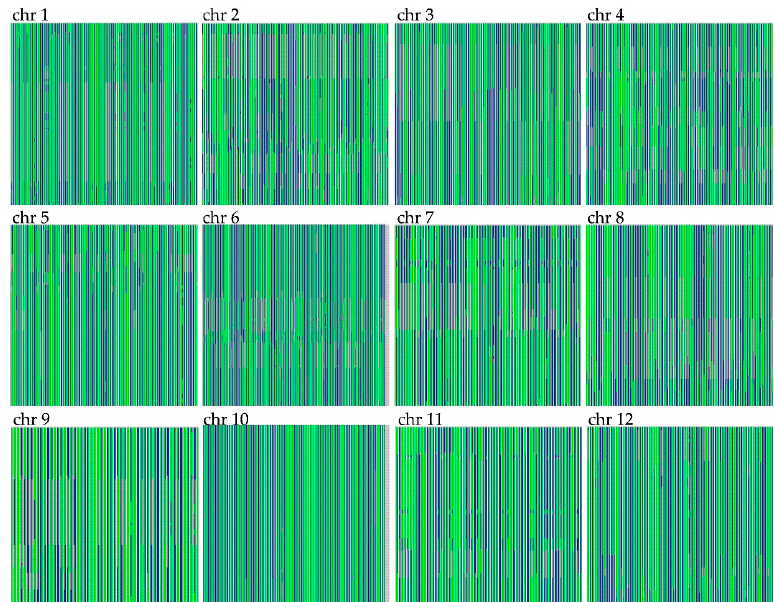
Figure A2. Haplotype maps for 12 linkage groups of the integrated genetic map for tetraploid potato. The haplotype maps consist of 12 maps from LG chr 1 to LG chr 12. Each two columns represent the genotype of an individual. Blank columns are used between two individuals. The first and second columns represent the paternal and maternal chromosome, respectively. Rows correspond to genetic markers. Green and blue boxes indicate one chromatid from parents, and gray boxes indicate missing data. Agronomy 2020 , 10 , x FOR PEER REVIEW